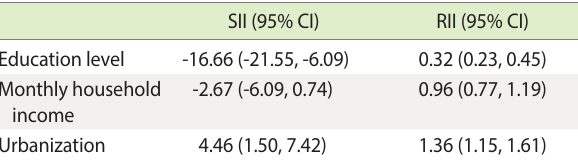
Table 3. Socioeconomic inequalities in obesity status among in